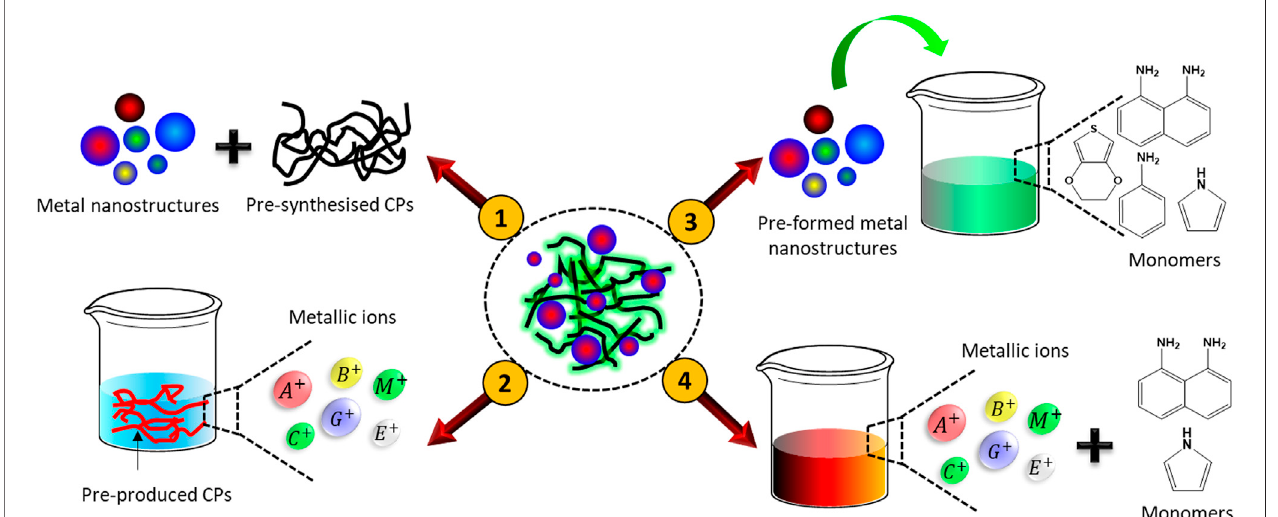
FIGURE 3 | Preparation strategies of CPs-metal